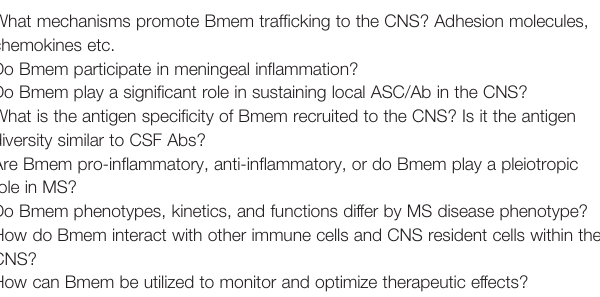
TABLE 2 | Bmem in MS: Unresolved questions. What mechanisms promote Bmem traf fi cking to the CNS? Adhesion molecules, chemokines etc. Do Bmem participate in meningeal in fl ammation? Do Bmem play a signi fi cant role in sustaining local ASC/Ab in the CNS? What is the antigen speci fi city of Bmem recruited to the CNS? Is it the antigen diversity similar to CSF Abs? Are Bmem pro-in fl ammatory, anti-in fl ammatory, or do Bmem play a pleiotropic role in MS? Do Bmem phenotypes, kinetics, and functions differ by MS disease phenotype? How do Bmem interact with other immune cells and CNS resident cells within the CNS? How can Bmem be utilized to monitor and optimize